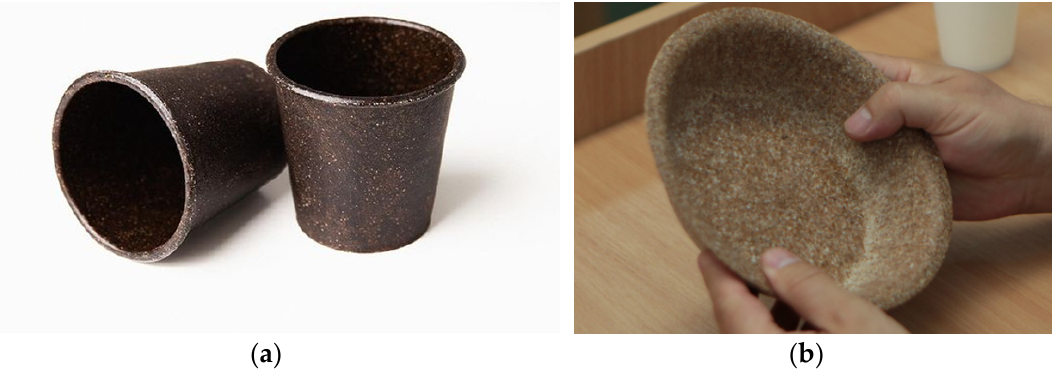
Figure 6. Biodegradable disposable tableware: ( a ) a laboratory prototype of disposable tableware based on biomaterial from spent coffee grounds ( Open source photo ) [50]; ( b ) biodegradable disposable tableware based on the meal ( Open source photo ) [58].